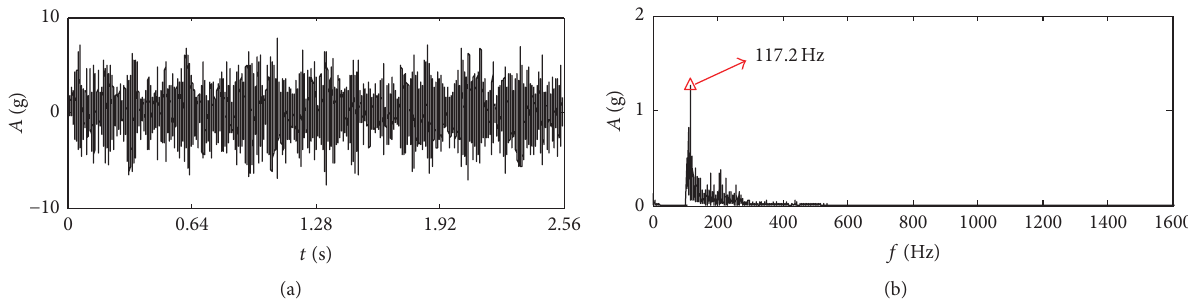
Figure 11: Detection results of the proposed method: (a) the output waveform of SR system; (b) the frequency